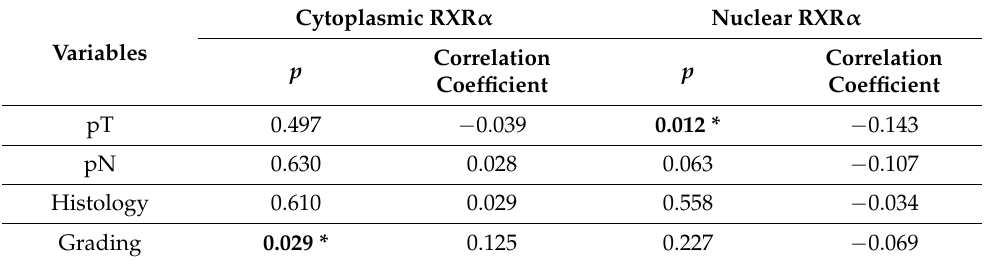
Table 2. High cytoplasmic versus nuclear RXR α expression in correlation to clinicopathological data.